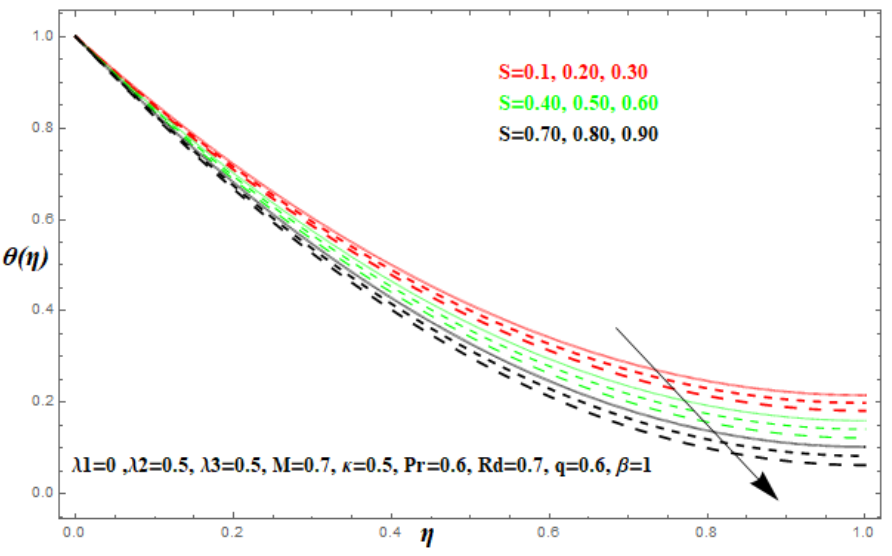
Figure 9. Changes in temperature gradient θ ( η ) for diverse measures of S .